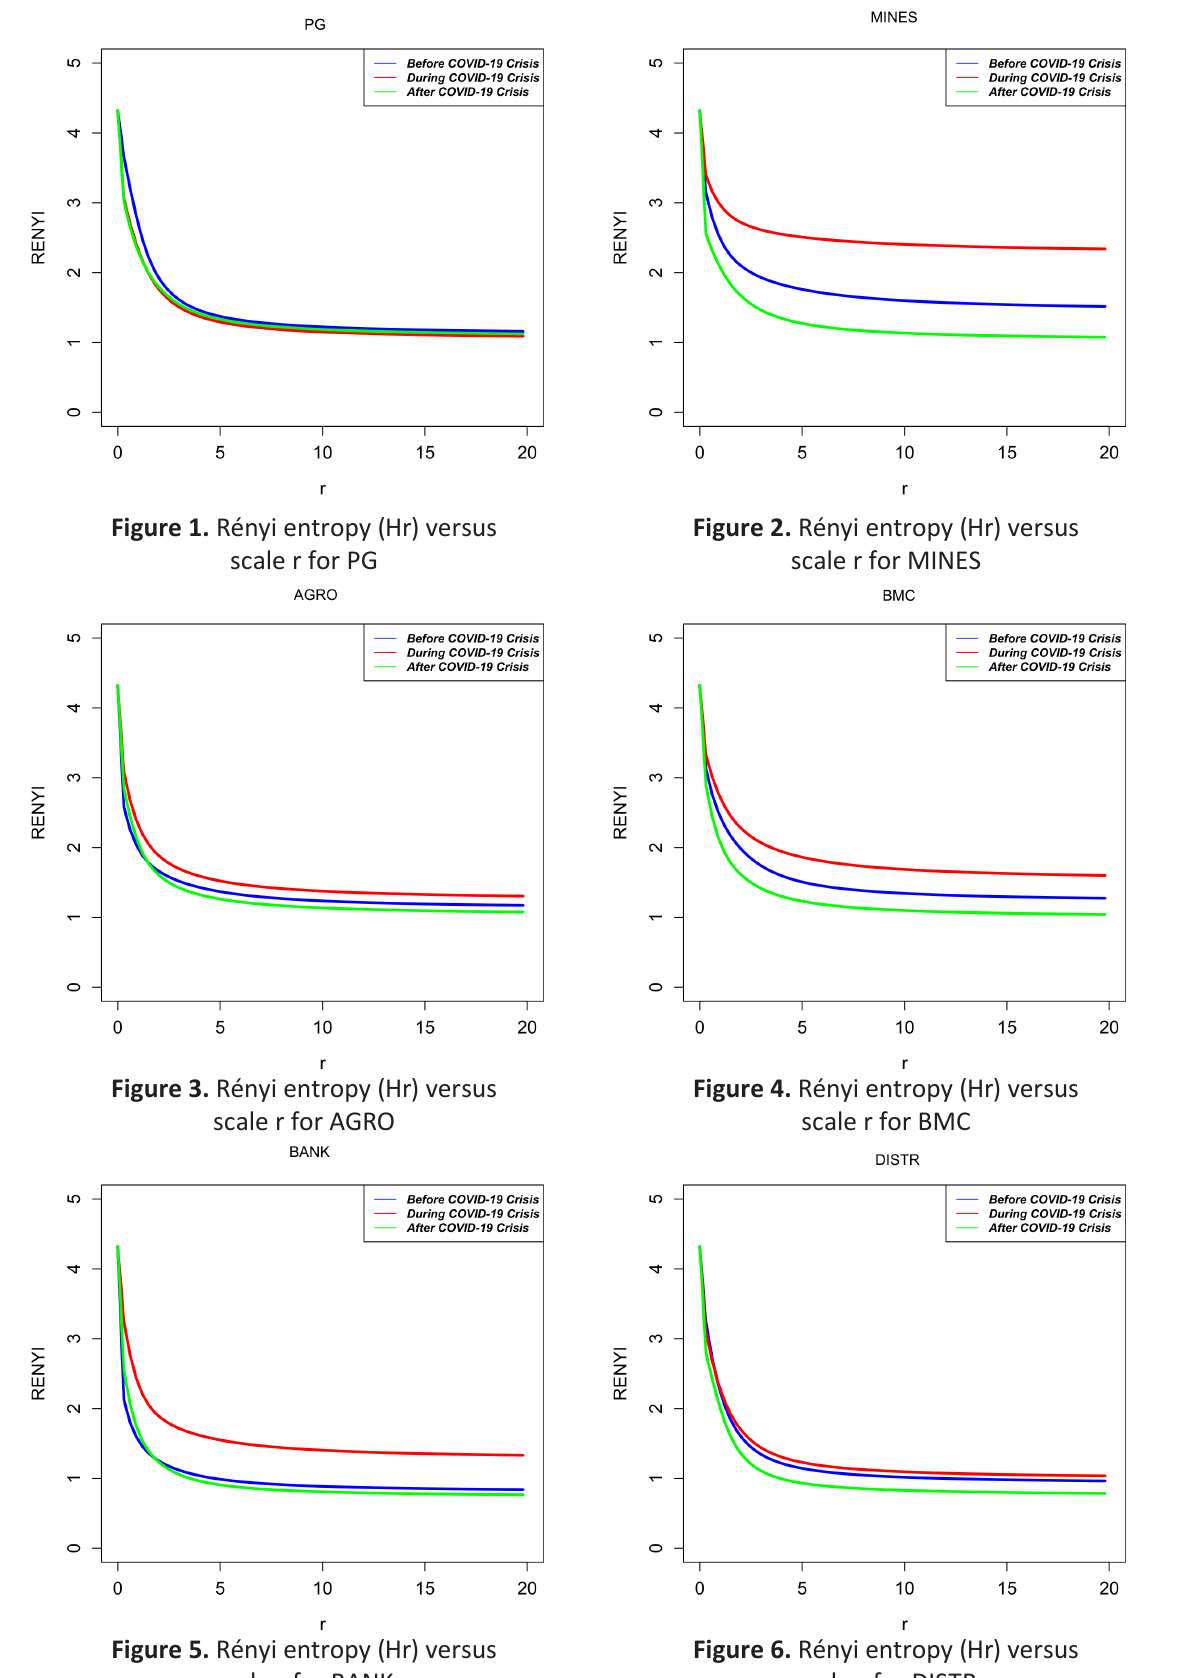
Figure 5. Rényi entropy (Hr) versus scale r for BANK